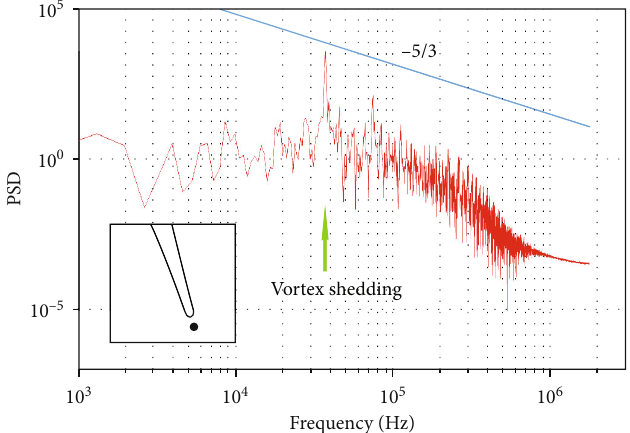
Figure 4: Power spectral density of the present SAS under fl ow condition MUR129.